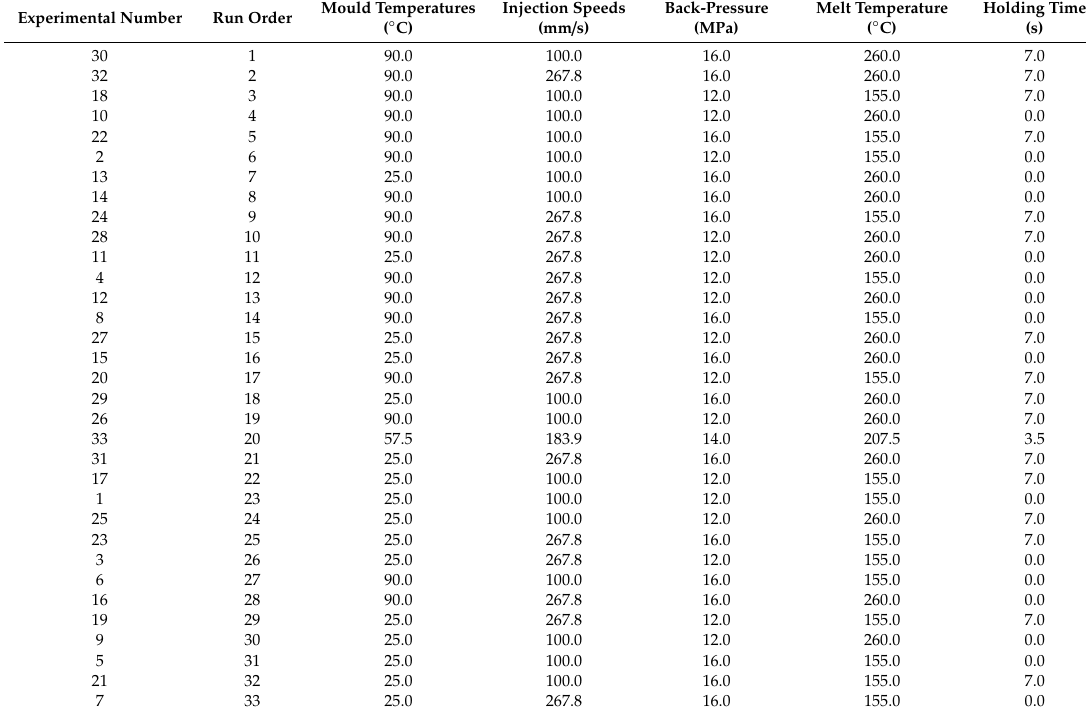
Table A2. Regression models derived from the DoE factorial design analysis. Regression model (A: Mould Temperature, B: Injection Speed, C: Back-Pressure, D: Melt Temperature and E: Holding